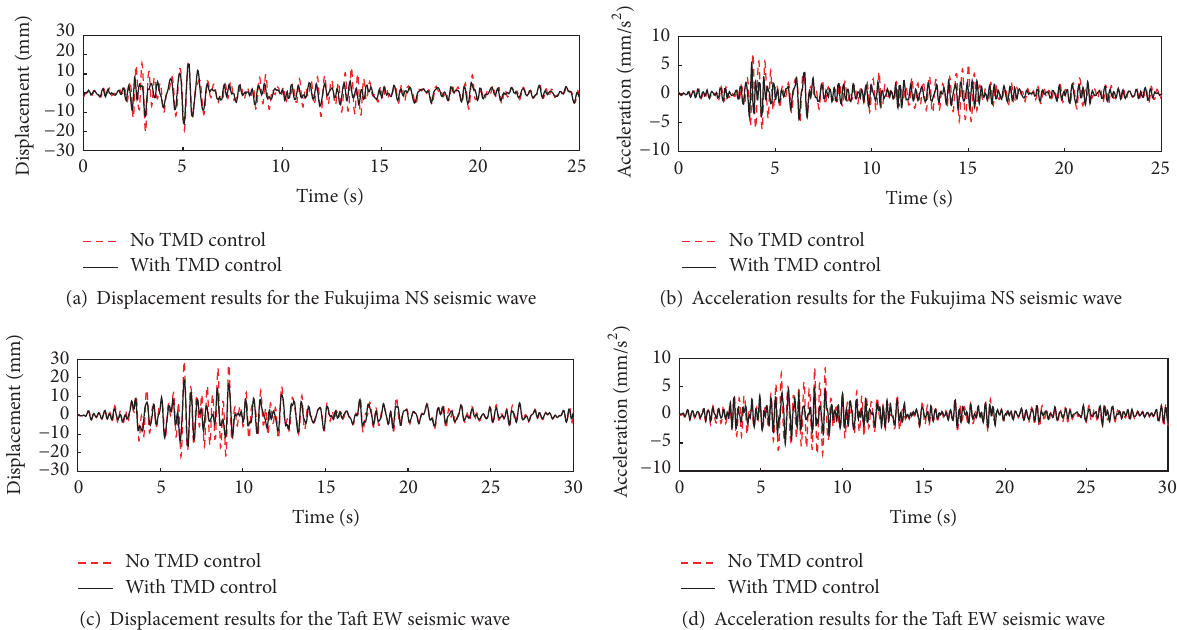
Figure9:AmplituderesponsesoftheplatformsubjectedtotheFukujimaNSandTaftEWseismicwaves:(a)displacementresultsforFukujima NS, (b) acceleration results for Fukujima NS, (c) displacement results for Taft EW, and (d) acceleration results for Taft EW.